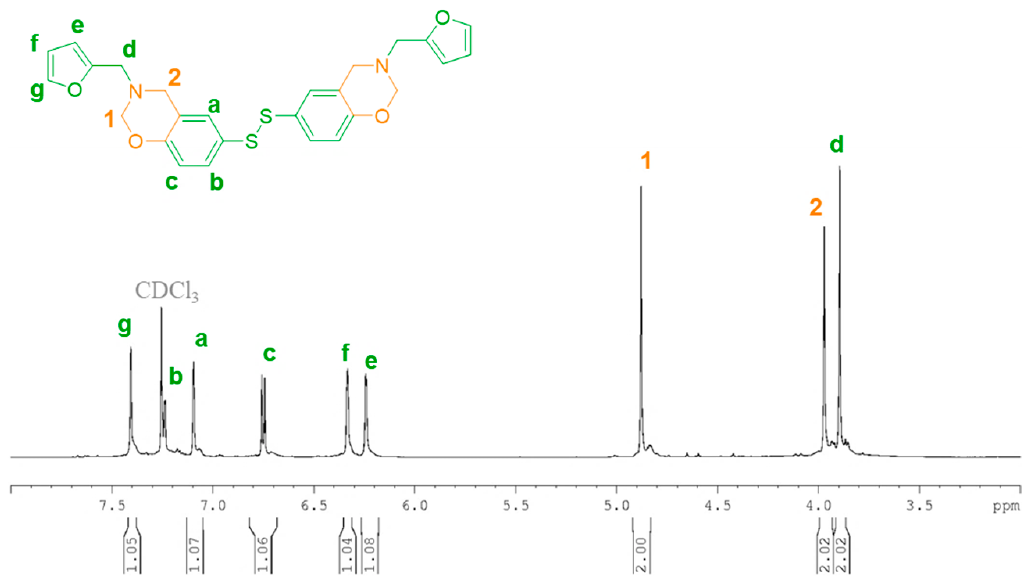
Figure A1. 1 H NMR spectrum in CDCl 3 of 4DPDS-fa.